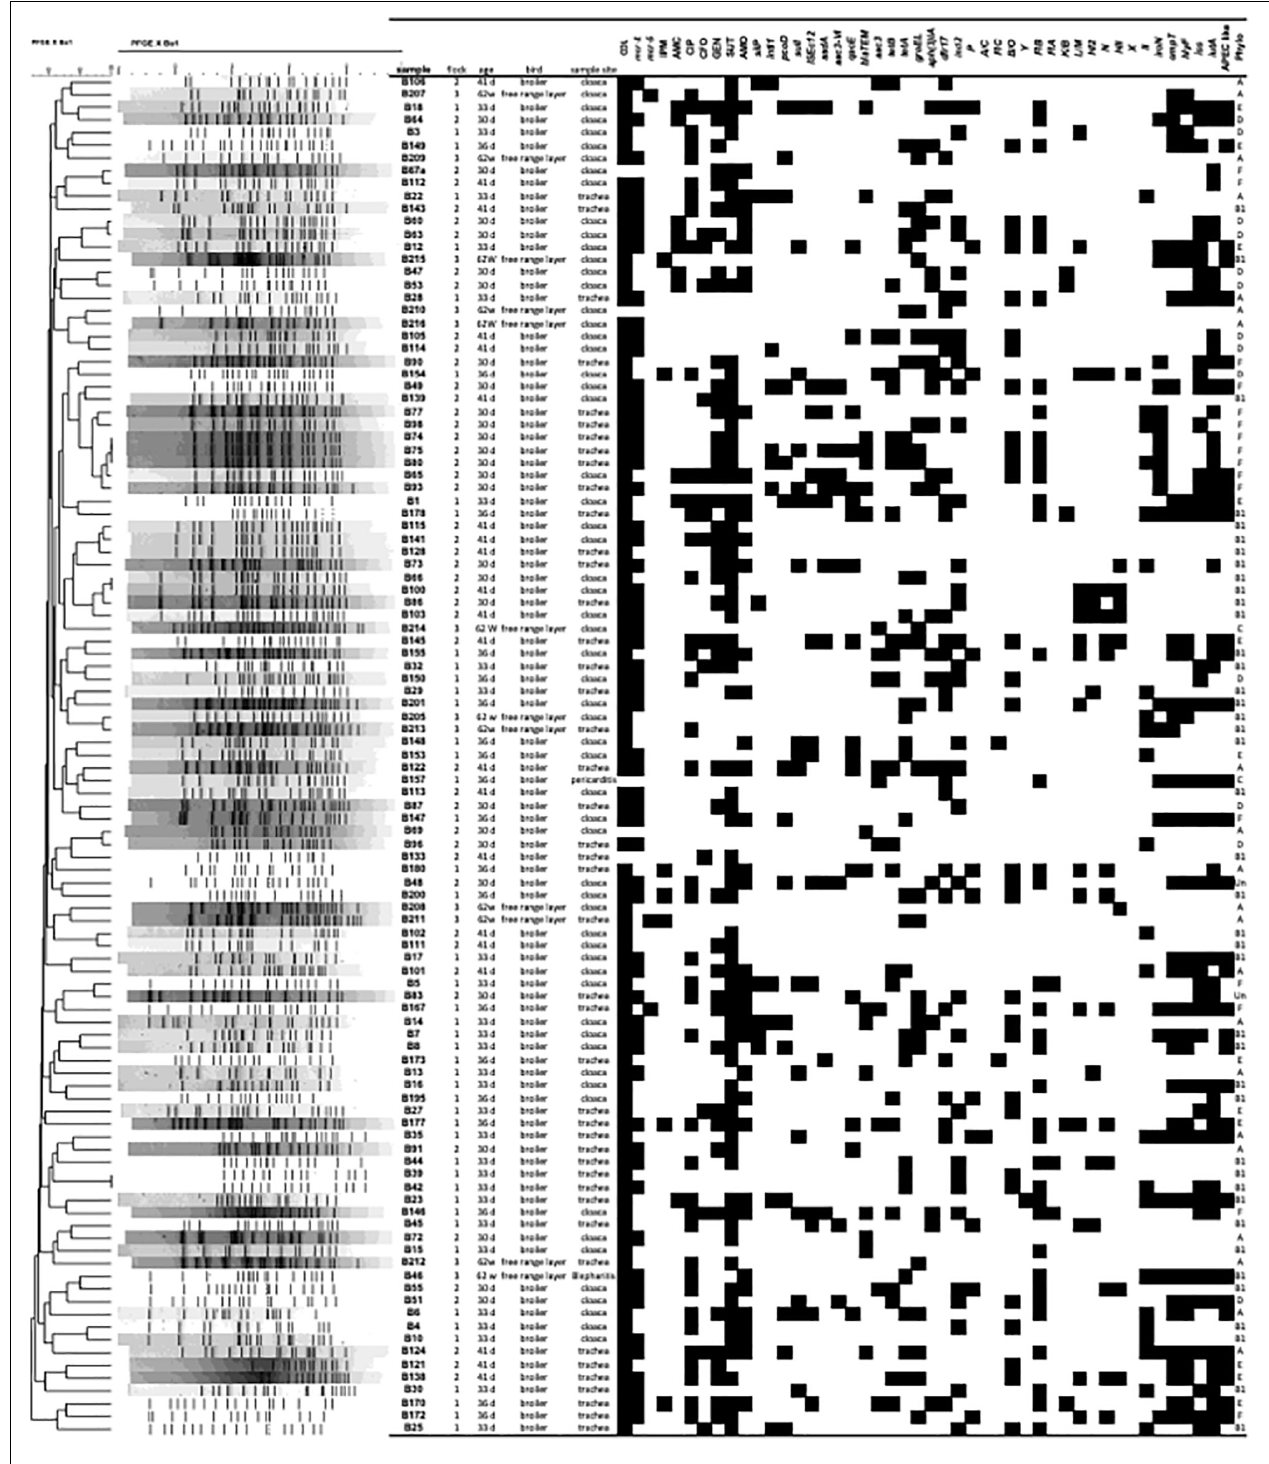
FIGURE 1 | Pulsed-field gel electrophoresis (PFGE) profile of 107 avian Escherichia coli isolates. The PFGE dendrogram was constructed by the unweighted-pair group method with arithmetic averages. The scale indicates levels of similarity within this set of isolates based upon Xba I enzyme restriction digestion of total bacterial DNA. The column Sample shows isolate designation; the column flock, indicates the farm the isolate came from (1–3) ; the column Age, days or weeks old of the bird; bird shows type of bird; Sample Site, site of bacterial isolation; the subsequent columns depict the antimicrobial resistance and PCR results for virulence genes (VAGs) tested, with presence indicated in black and absence indicated in white; Phylo, phylogenetic group.